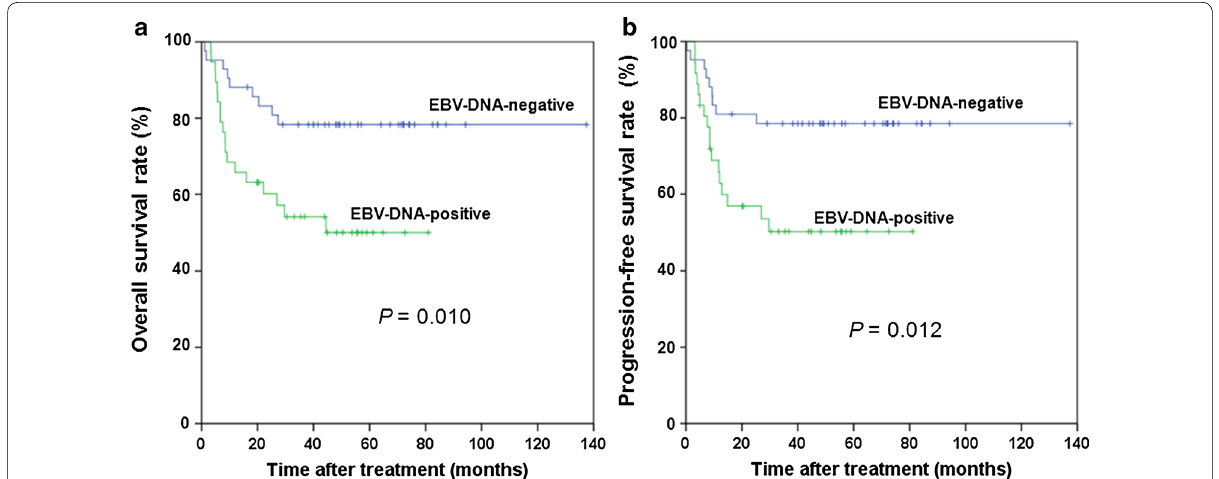
Fig. 4 Survival curves of 81 patients with ENKTL as stratified by plasma EBV-DNA status. a Overall survival; b Progression-free